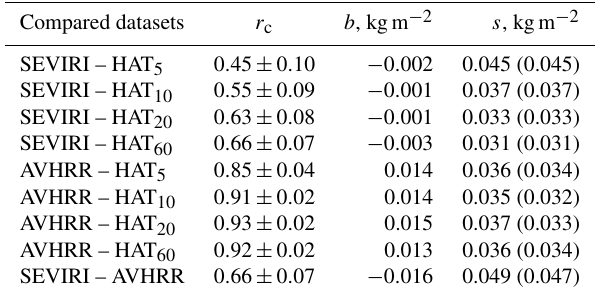
Table 1. Characteristics of the data agreement: correlation coeffi- cient r c , bias b (satellite data minus ground-based data and SEVIRI data minus AVHRR data), and rms s obtained for the WH season (standard deviation s 0 is given in brackets). Total number of data points N is 63, and the mean LWP values for HATPRO datasets are in the range 0.021–0.023kgm − 2 .